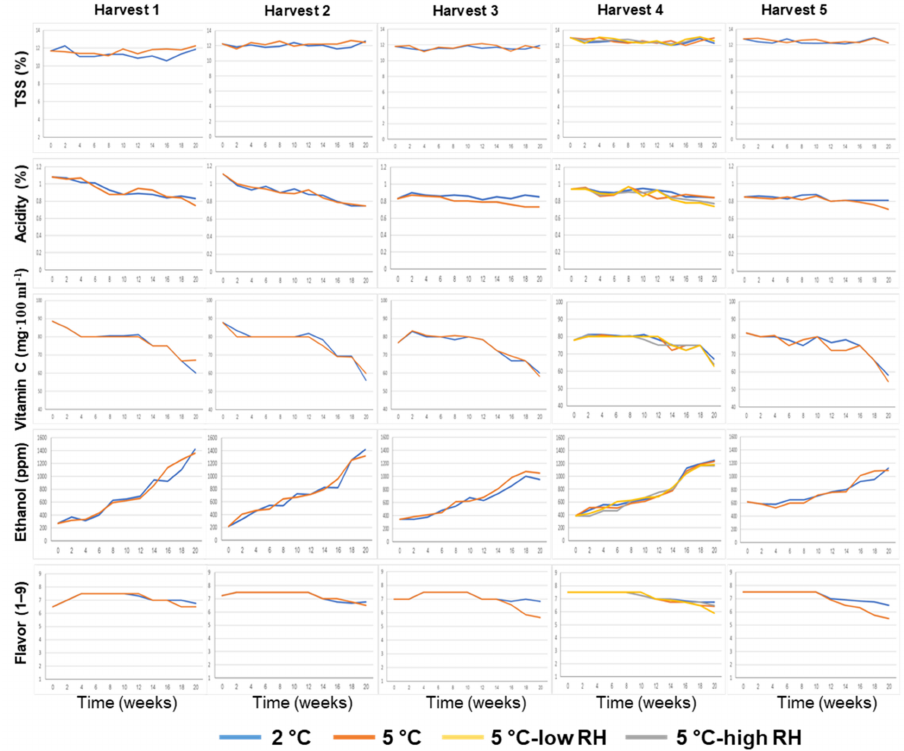
Figure 3. Effects of various preharvest and postharvest features on the biochemical composition and flavor of ‘Valencia’ oranges harvested from five different orchards. The harvest times and yields of the different orchards are presented in Table 1. The postharvest features included the storage temperature (2 ◦ C or 5 ◦ C) and storage RH (70%, 90%, or 95%). Fruit quality was evaluated every 2 weeks after 1 additional week of storage under shelf conditions (20 ◦ C) for a period of 20